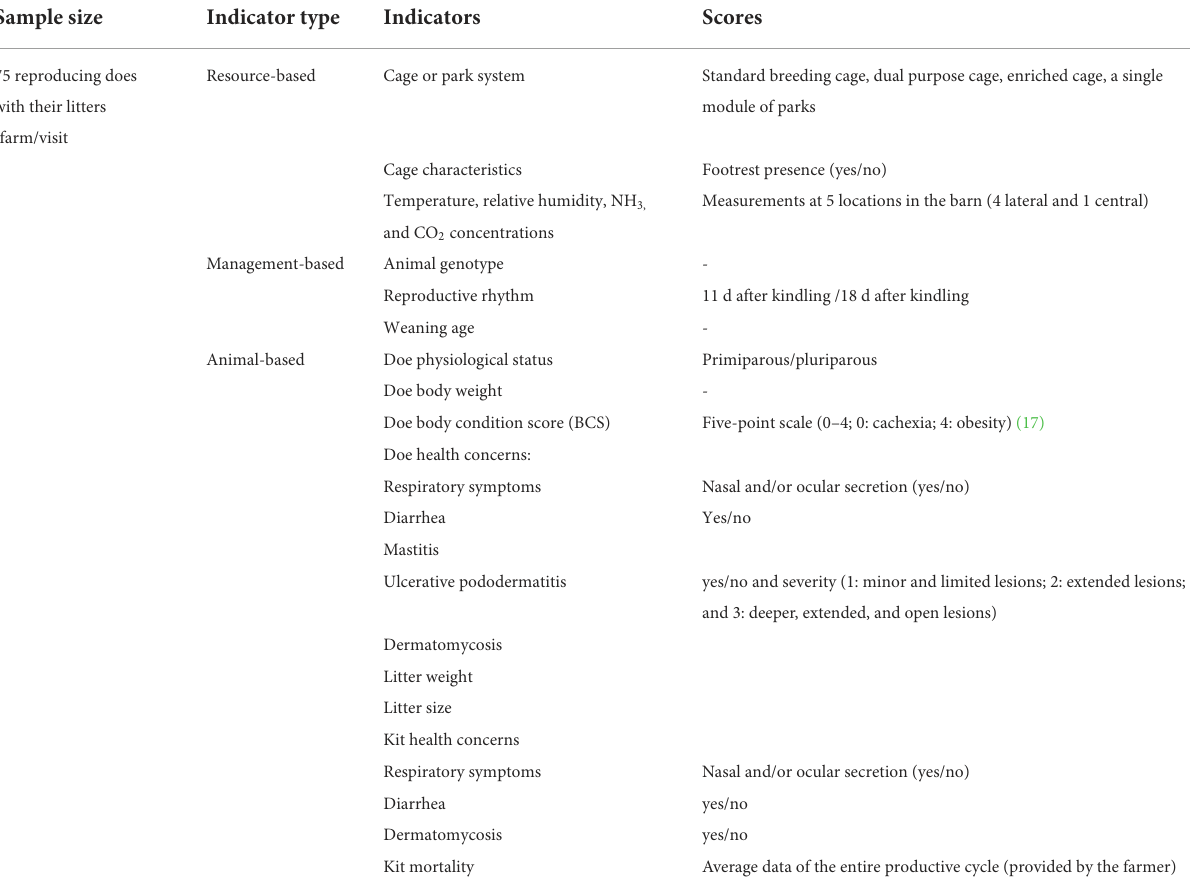
TABLE 2 Health and behavioral animal-based indicators and resource- and management-based data recorded on farms with reproducing does and kits the week before weaning (pre-weaning